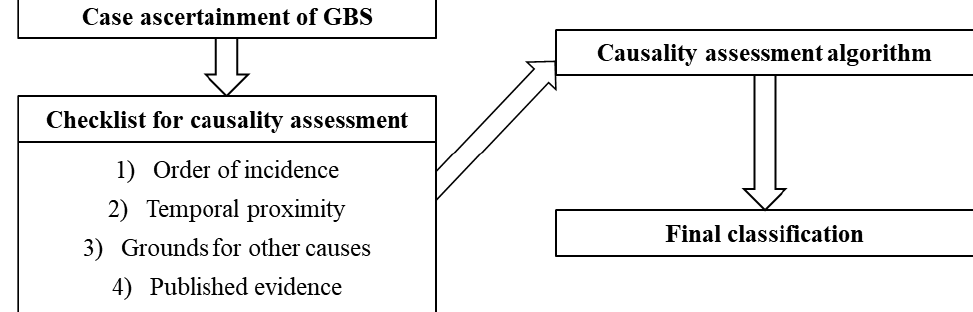
Figure 2. Structure of the causality assessment guidelines for Guillain–Barré syndrome following immunization. Table 1. Case ascertainment of Guillain–Barr é